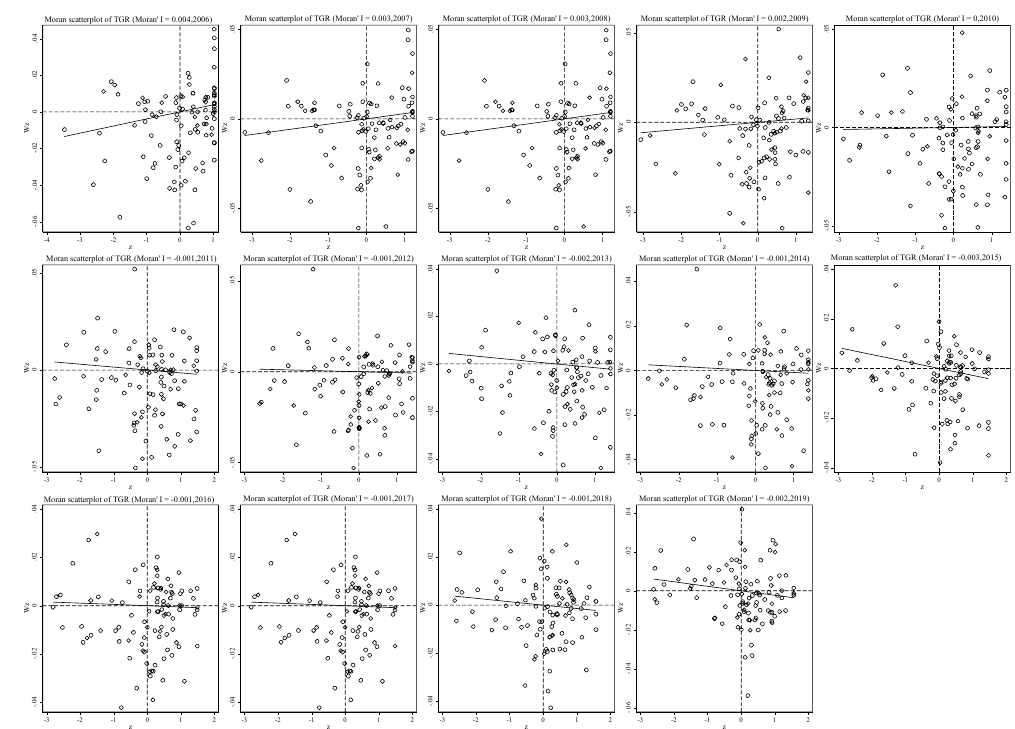
Figure 7. Distribution Change of TGR Moran’s I Scatter plot from 2006 to 2019.